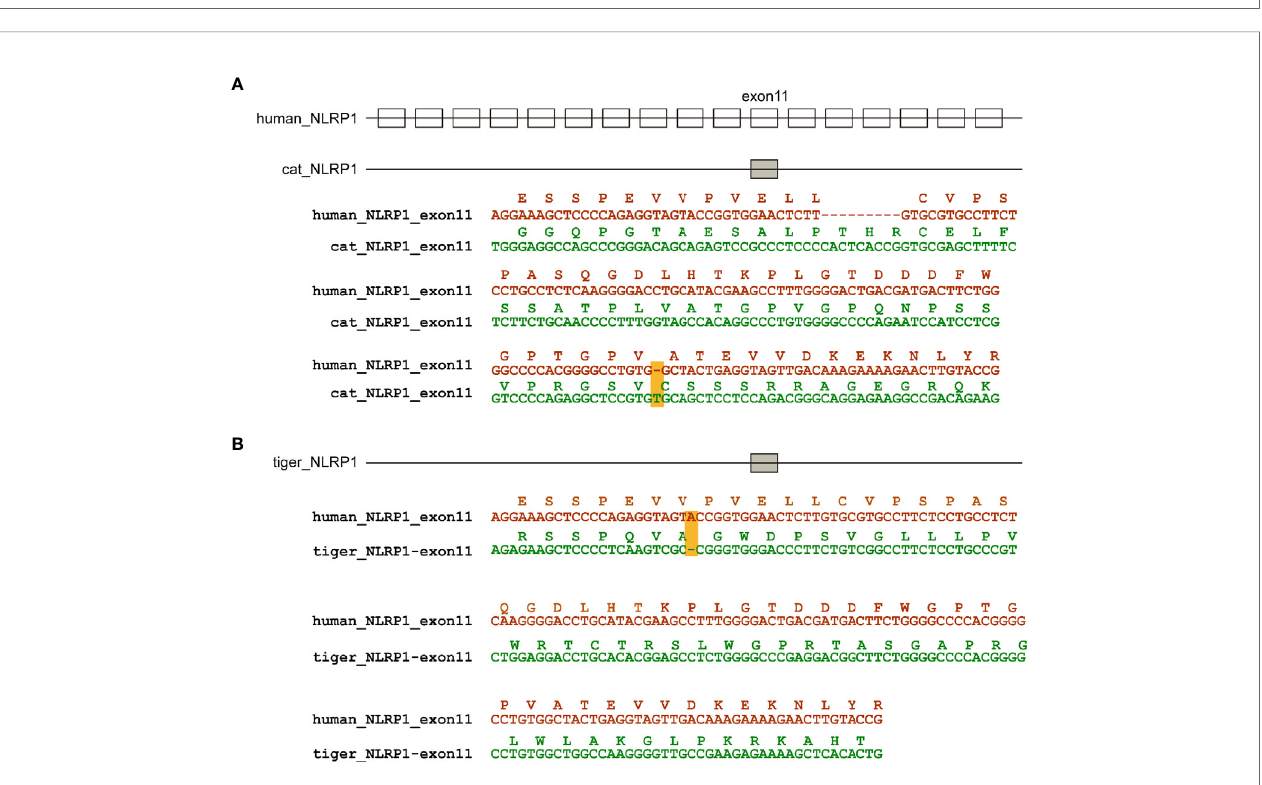
FIGURE 3 | NLRP1 were absent in cat and dog genomes. (A) Natural deletion of NLRP1 in cat genomes. (B) Natural deletion of NLRP1 in tiger genomes. Exons are represented by boxes. Nucleotide sequences of cat, tiger and human were aligned. Amino acids encoded by exon 11 are shown as boxes. Frame-shift mutations are highlighted by yellow